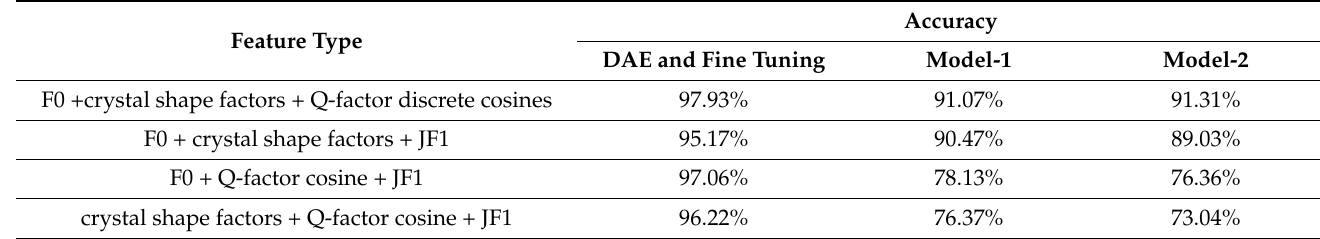
Table 13. Comparison of Model-1, Model-2 and our model proposed with Triple Feature